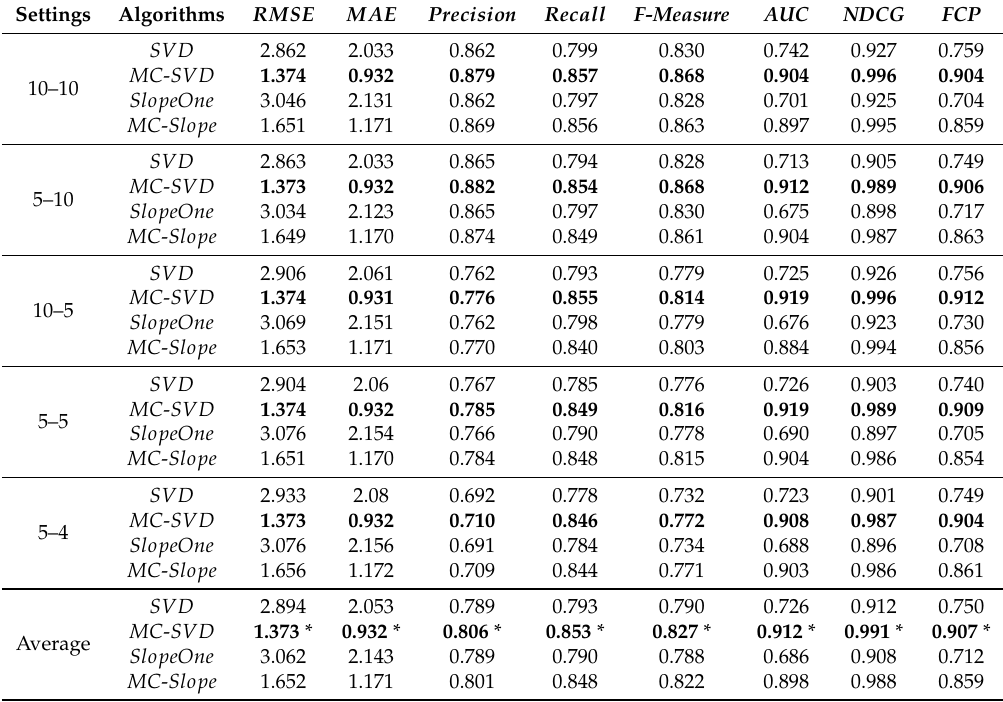
Table 5. Evaluation results.